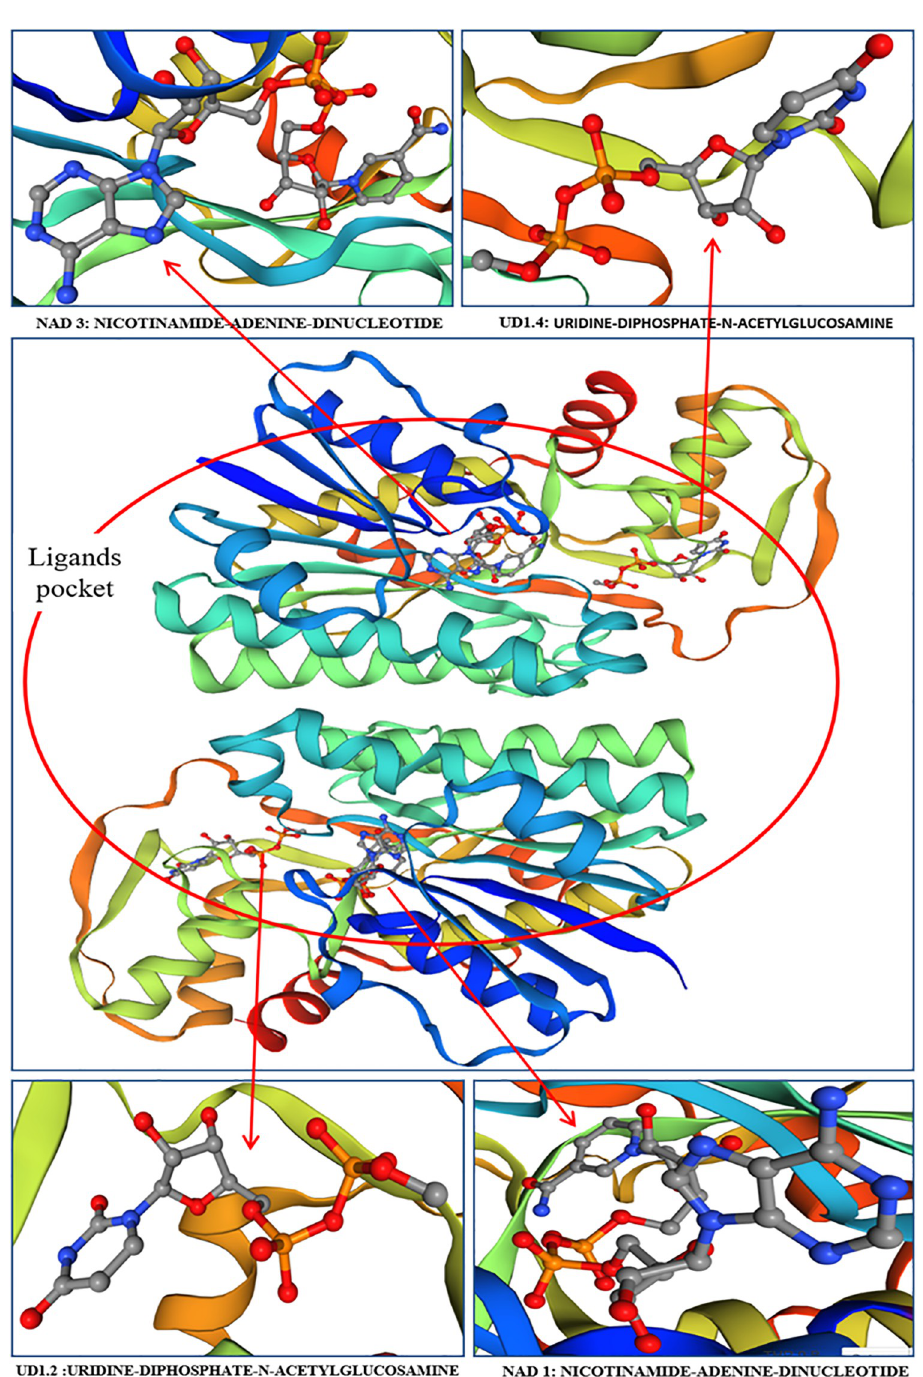
Fig 5. Predicted 3D model of SoFLDH generated by the SWISS-MODEL software. The arrows represent the ligands pocket with predicted active binding residues, the Nicotinamide-adenine-dinucleotide (NAD) domain and the Uridine-diphosphate-n-acetylglucosamine (UD) domain.